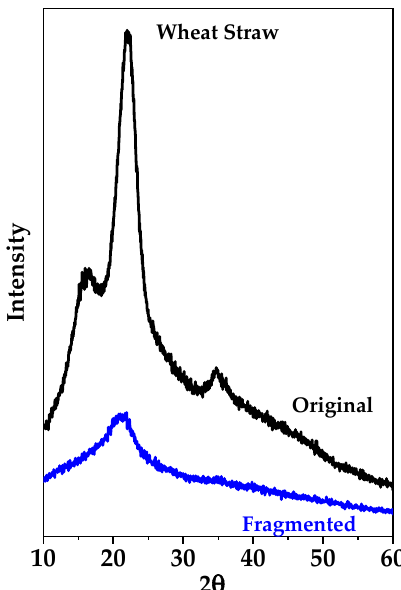
Figure 5. XRD characterization of the original wheat straw and solid fraction (rich in sugars) after pretreatment with [EMIM]OAc.